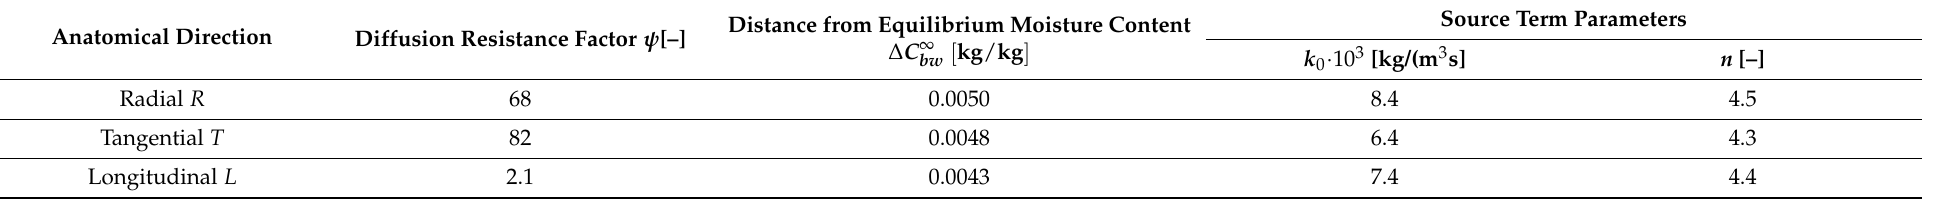
Table 2. Coefficients obtained for the pine